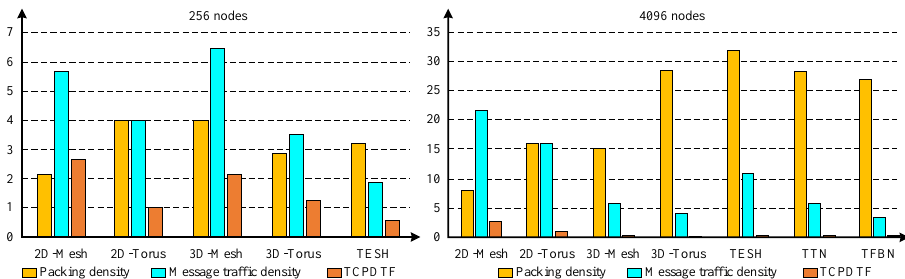
Figure 5. A graphical illustration of the performance comparison of the packing density, message traffic density, and the traffic congestion and packing density trade-off factor (TCPDTF) of various